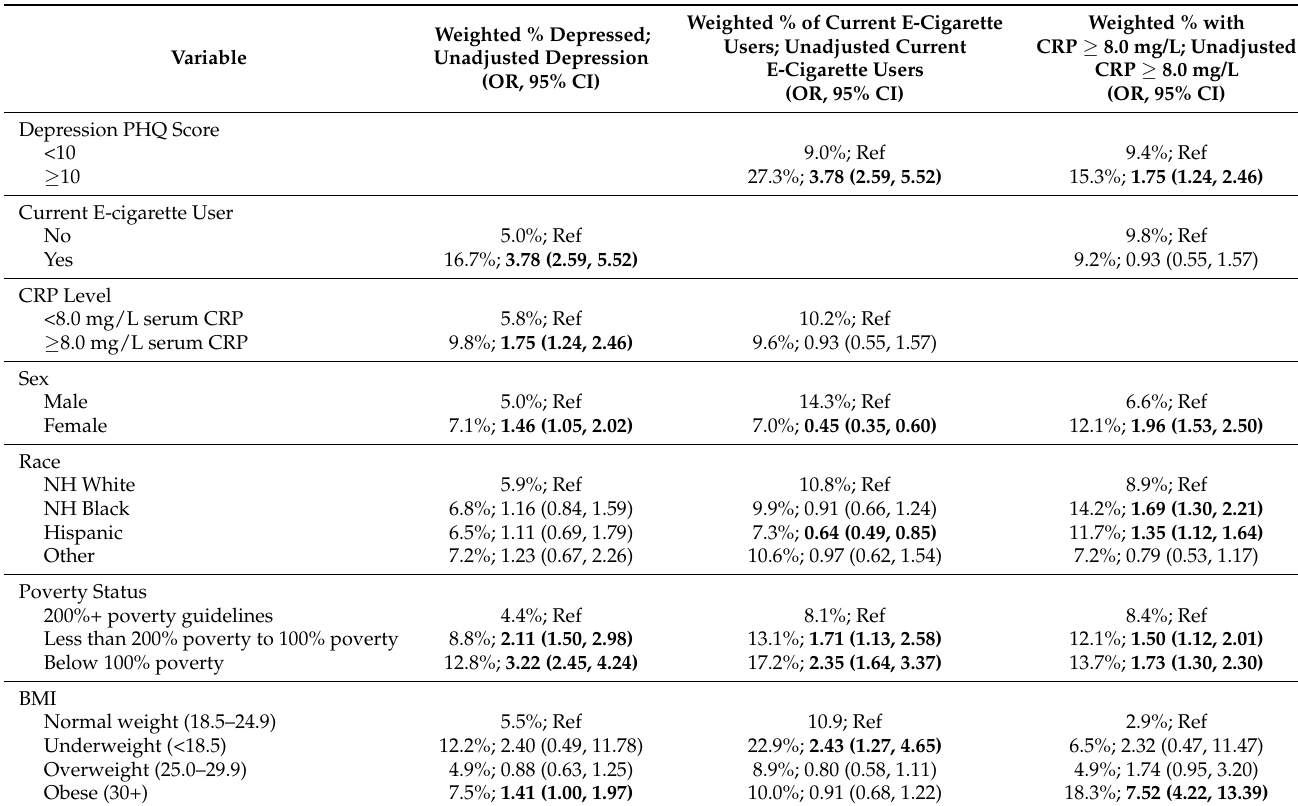
Table 2. Bivariate Analyses Between Rates of Depression, Current E-cigarette Status, and Elevated CRP and Independent Variables.